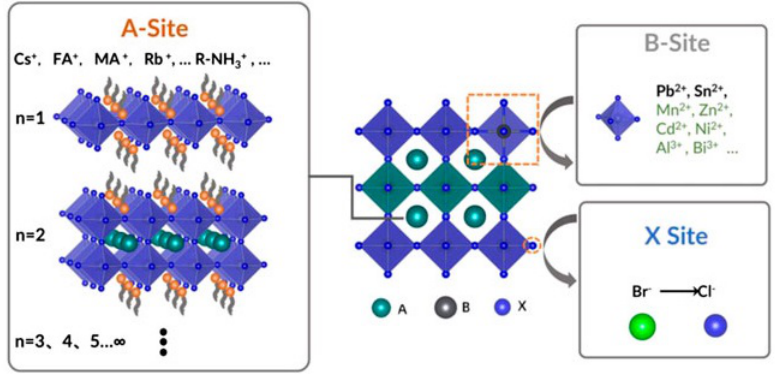
Figure 3. Illustration of the structure of perovskite. Reprinted from [46] with permission from